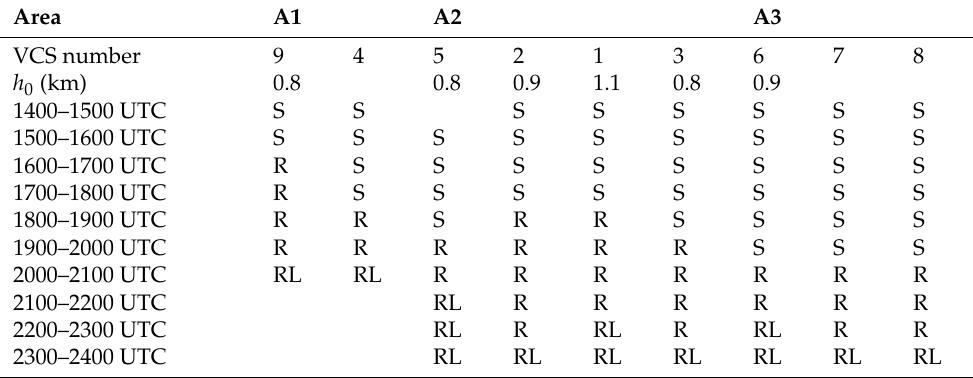
Figure 9. Temporal evolutions of the model-simulated rainband positions at 1-h intervals in ( a ) Area 1 (A-A ′ to G-G ′ for 1400 to 2000 UTC), ( b ) Area 2 (A-A ′ to K-K ′ for 1400 to 2400 UTC), and ( c ) Area 3 (A-A ′ to J-J ′ for 1500 to 2400 UTC) on 19 October 2004. The terrain heights (m) are shaded (scale to the right). The solid, straight lines depict the vertical cross-sections constructed in this study (labeled as VCS1 to VCS9). Table 2. The classification results of rainband behavior in the model along the nine cross-sections (VCS1 to VCS9, from west to east) in the three areas (A1, A2, and A3, cf. Figures 8 and 9). The letters “S”, “R”, and “RL” denote three phases when the rainband remained standing, retreated, and retreated back to land, respectively. The parameter h 0 is the characteristic terrain height (km) used to compute Fr